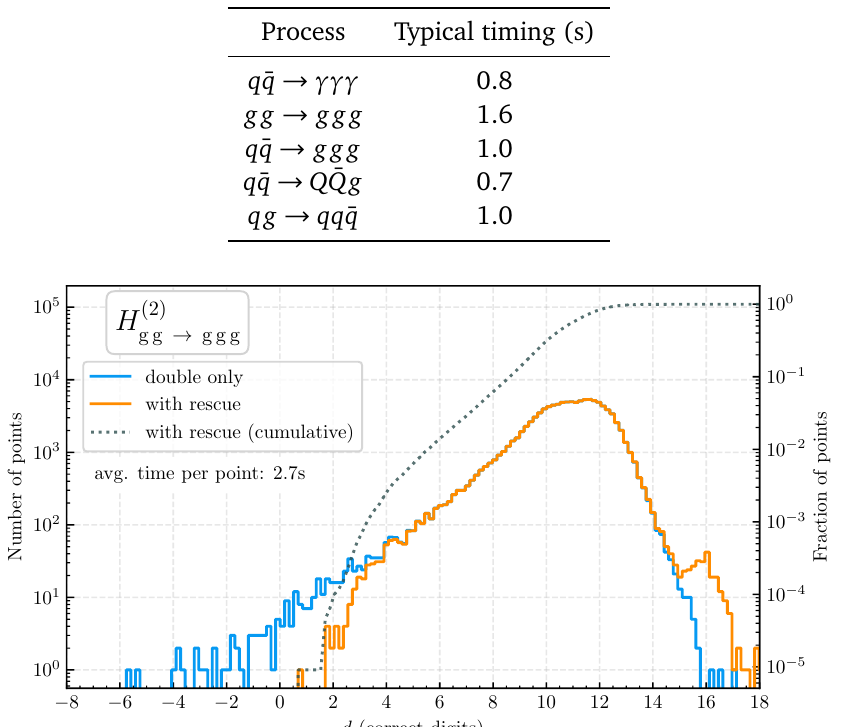
Figure 2: Logarithmic distribution of correct digits (see eq. (5)) of the five-gluon two- loop squared finite remainder on a sample of 110k points. The blue line corresponds to evaluation with double precision. The orange line represents evaluation with the rescue system enabled. The gray dashed line is the cumulative distribution of the latter. Average core time for evaluation on a single phase-space point with rescue system enabled as measured when evaluating all sample points in parallel using all 32 threads of Intel(R) Xeon(R) Silver 4216 CPU @ 2.10GHz . This figure is from ref. [ 39 ] licensed under CC-BY 4.0